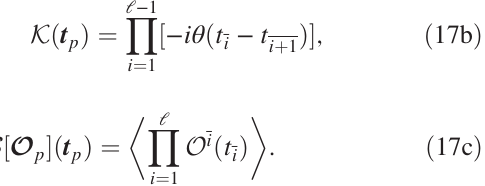
FIG. 1. ZF time ordering. For a given l -tuple of times t ¼ ð t … ; t 1 ; l Þ , only that permutation p in Eq. (17) yields a ≠ 0 , for which the permuted times, nonzero contribution, K ð t p Þ t t ¯1 ; … ; t ¯ l Þ , satisfy t ¯1 > t ¯2 > (cid:2) (cid:2) (cid:2) > t ¯ l . In the corresponding p ¼ ð t operator product, S ½ O , larger times appear to the left of p (cid:3)ð p Þ smaller ones. Thus, the right-to-left order of operators in the product matches the order in which their times appear on the time axis, drawn with times increasing toward the